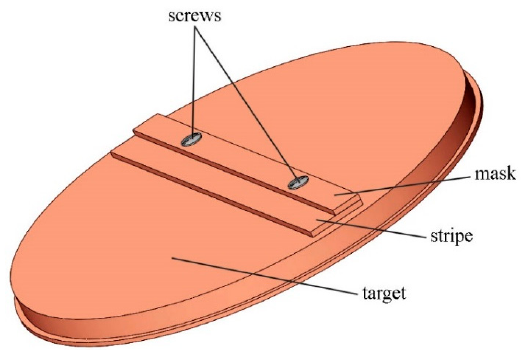
Figure 4. Schematic of the target with the masked stripe fastened on its surface for measurement of the sputtering rate distribution.